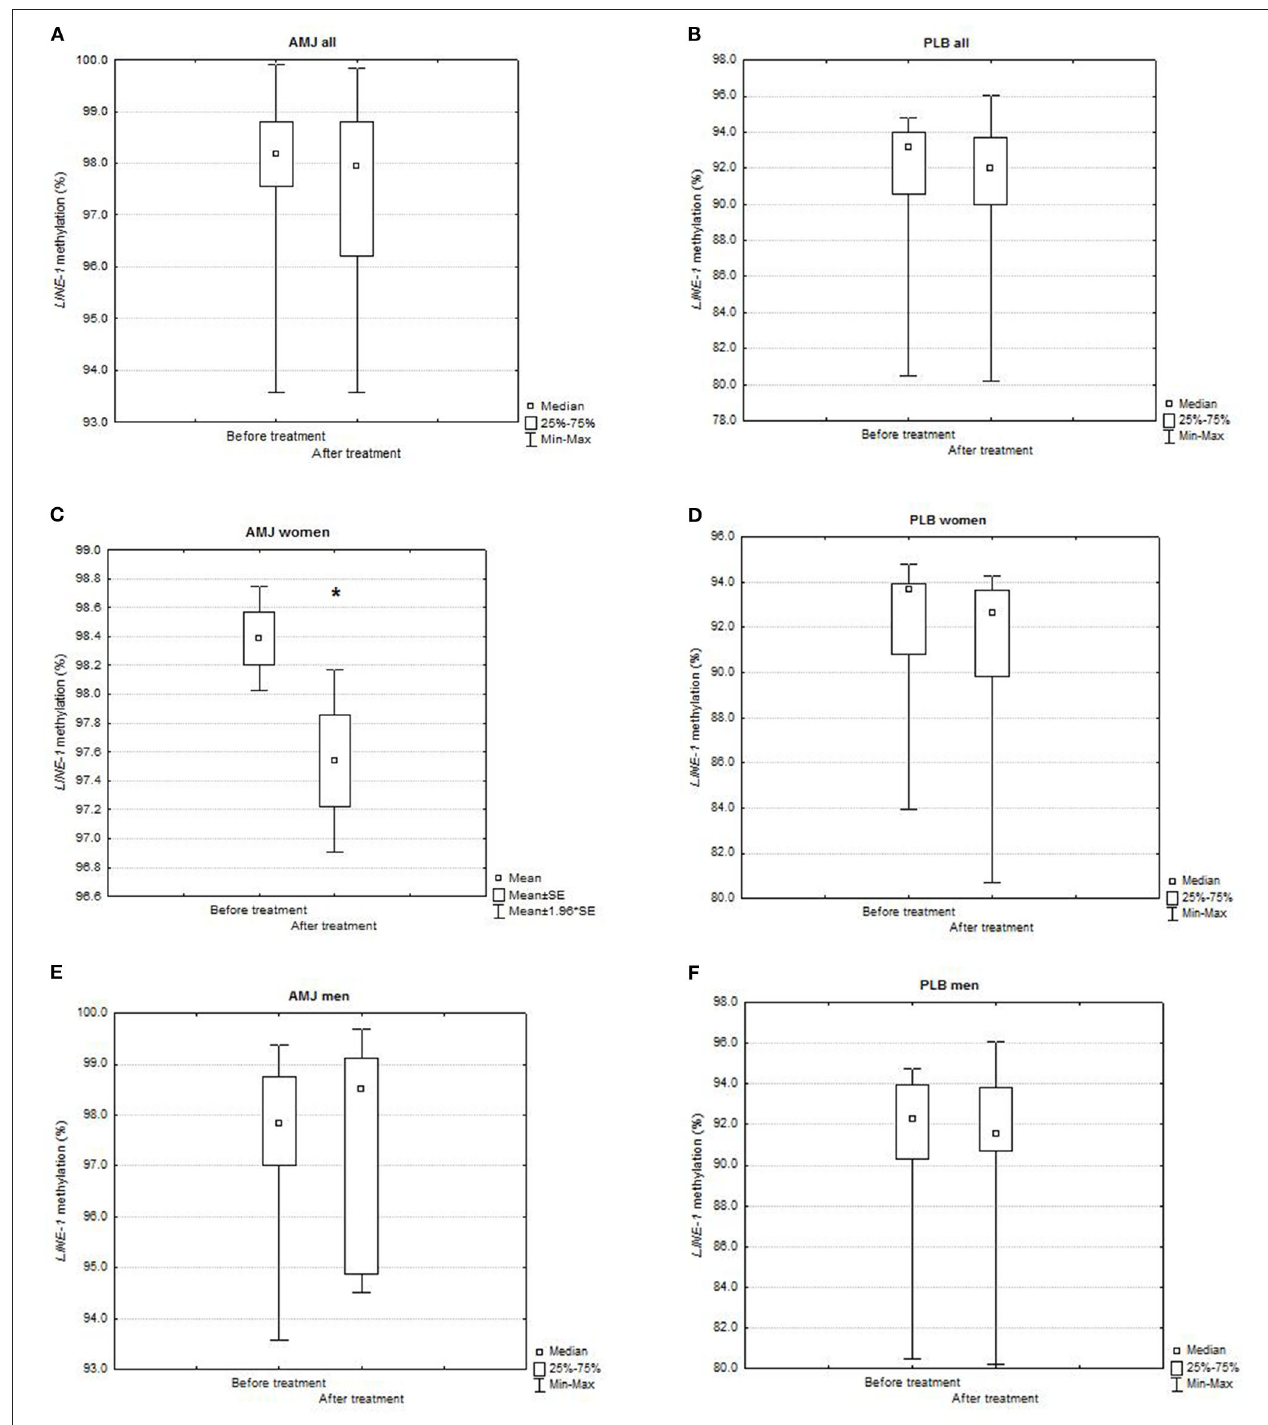
FIGURE 2 | Comparison of LINE-1 methylation levels (%) before and after treatment in: (A) all subjects on AMJ treatment ( N = 34; Wilcoxon matched pairs test, P = 0.14), (B) all subjects on PLB treatment ( N = 20; Wilcoxon matched pairs test, P = 0.10), (C) women on AMJ treatment ( N = 22; t -test for dependent samples, P = 0.01), (D) women on PLB treatment ( N = 10; Wilcoxon matched pairs test, P = 0.11), (E) men on AMJ treatment ( N = 12; Wilcoxon matched pairs test, P = 0.53), (F) men on PLB treatment ( N = 10; Wilcoxon matched pairs test, P = 0.65). AMJ, polyphenol-rich Aronia melanocarpa juice treatment; PLB, polyphenol-free beverage, placebo treatment; mean represents normally distributed LINE-1 methylation levels (%); median represents non-normally distributed LINE-1 methylation levels (%); SE, standard error; statistical significance at P < 0.05 ( * ); N , number of subjects.